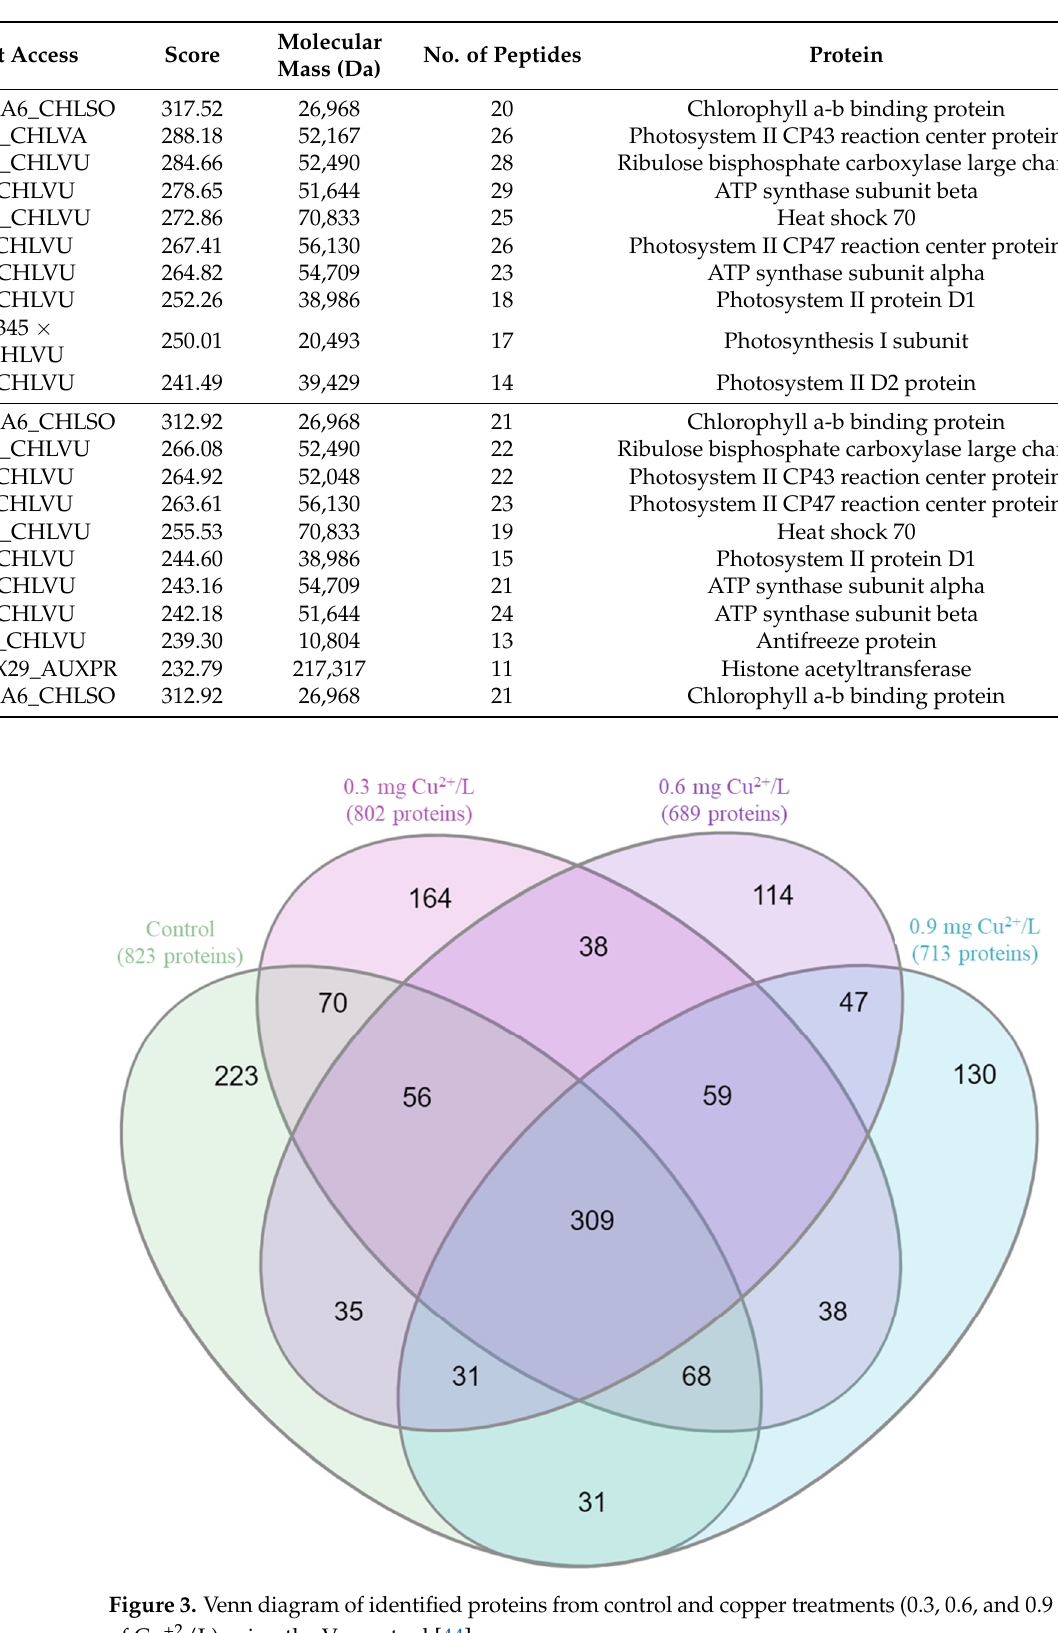
Table 2. Identified proteins related to protein biosynthesis. Protein